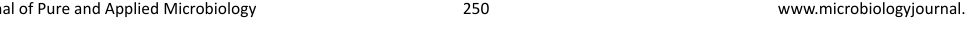
Fig. 1. Nodule’s number (a), nodule’s dry weight (b) of bean inoculated with different strains of Rhizobium obtained from nodules isolated from plants grown in different Fez regions. All data represent the mean ± SD of 3